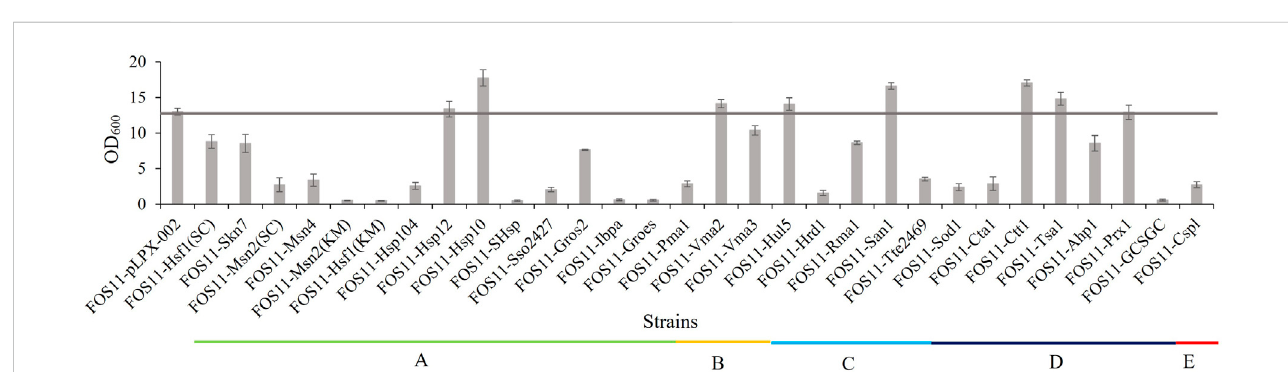
The cell density of engineered and control strains after 72 hcultured at35 ° C. (A). Engineeredstrains transformed with plasmids containing differentheat shock protein genes. (B) . Engineered strains transformed with plasmids containing different ATPase genes. (C) . Engineered strains transformed with plasmids containing different ubiquitin ligase genes. (D) . Engineered strains transformed with plasmids containing different antioxidant enzyme genes. (E) . Engineered strains transformed with plasmids containing different nucleic acid protector